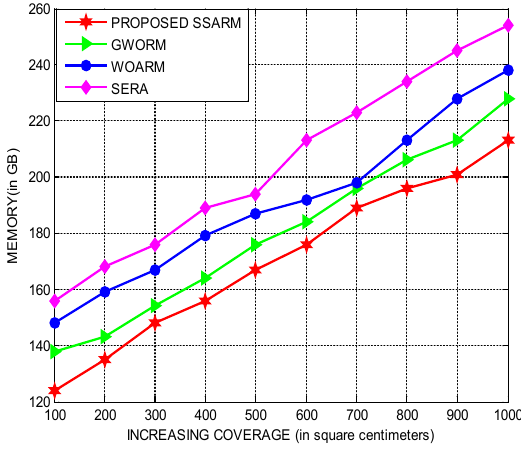
Figure 9. Proposed SSARM-Memory Utilized with Increasing Coverage